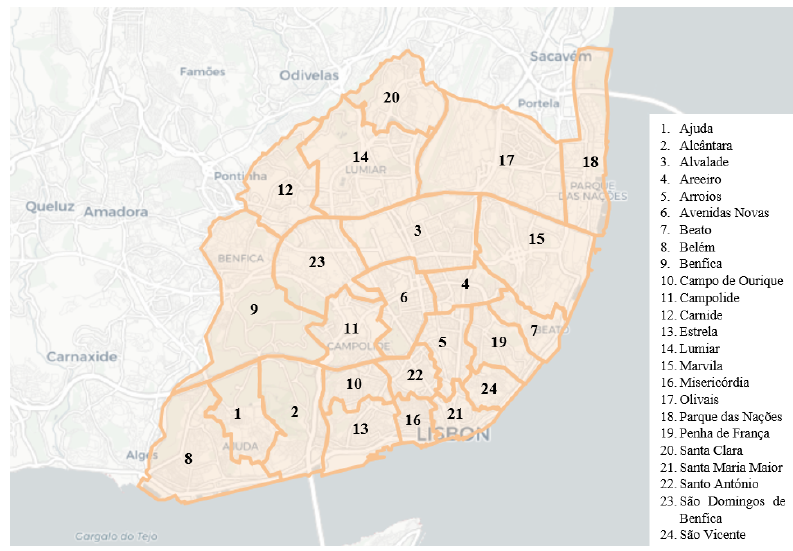
Figure 2. Lisbon’s